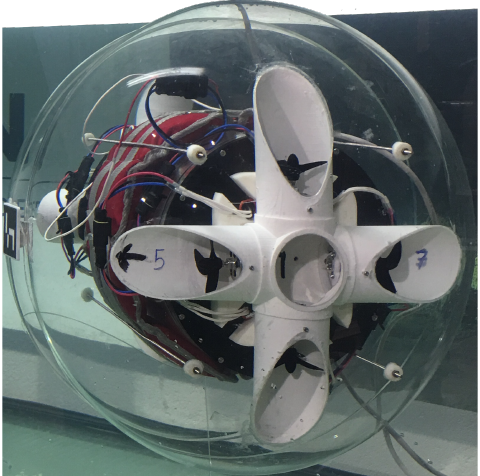
Figure 1. Spherical underwater vehicle prototype during pool tests.